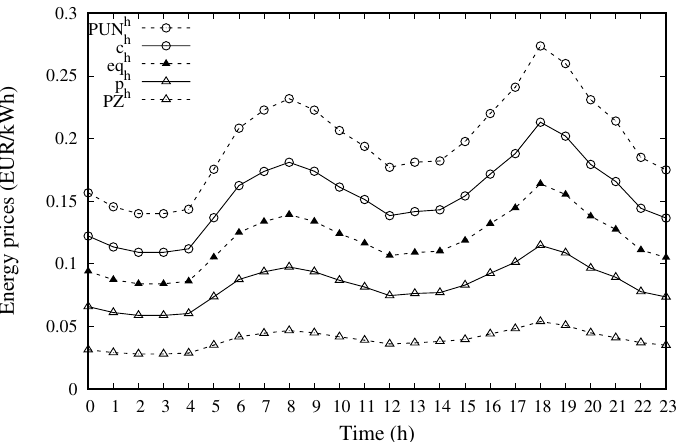
Figure 2. Example of daily trends for the costs and prices of electrical